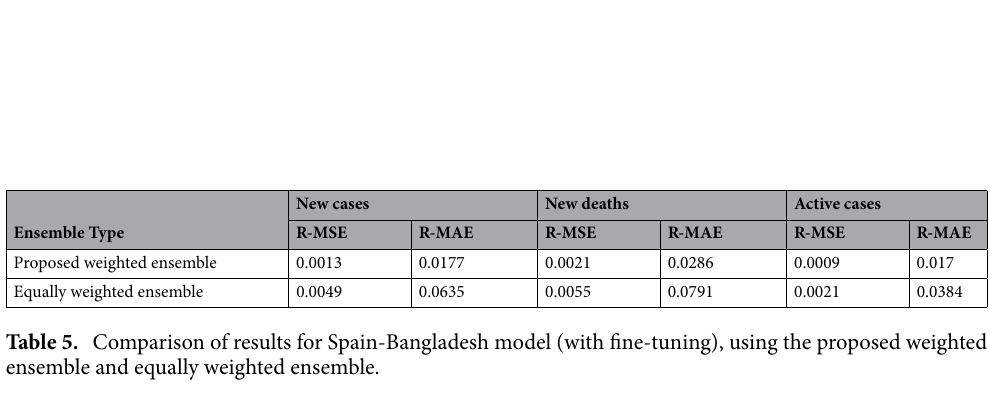
Figure 4. Prediction error (R-MSE) vs Look-back period for Spain-Bangladesh model.